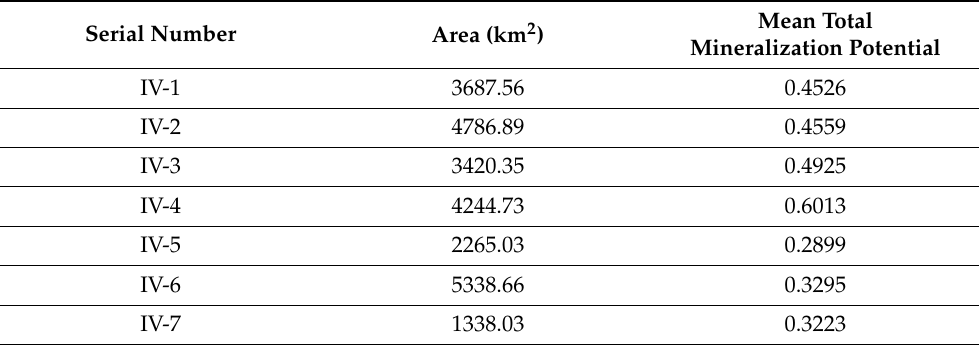
Figure 7. ( a ) Total mineralization potential and ( b ) geological characteristics of metallogenic belts. This figure was changed. Table 8. Attributes of metallogenic belts.